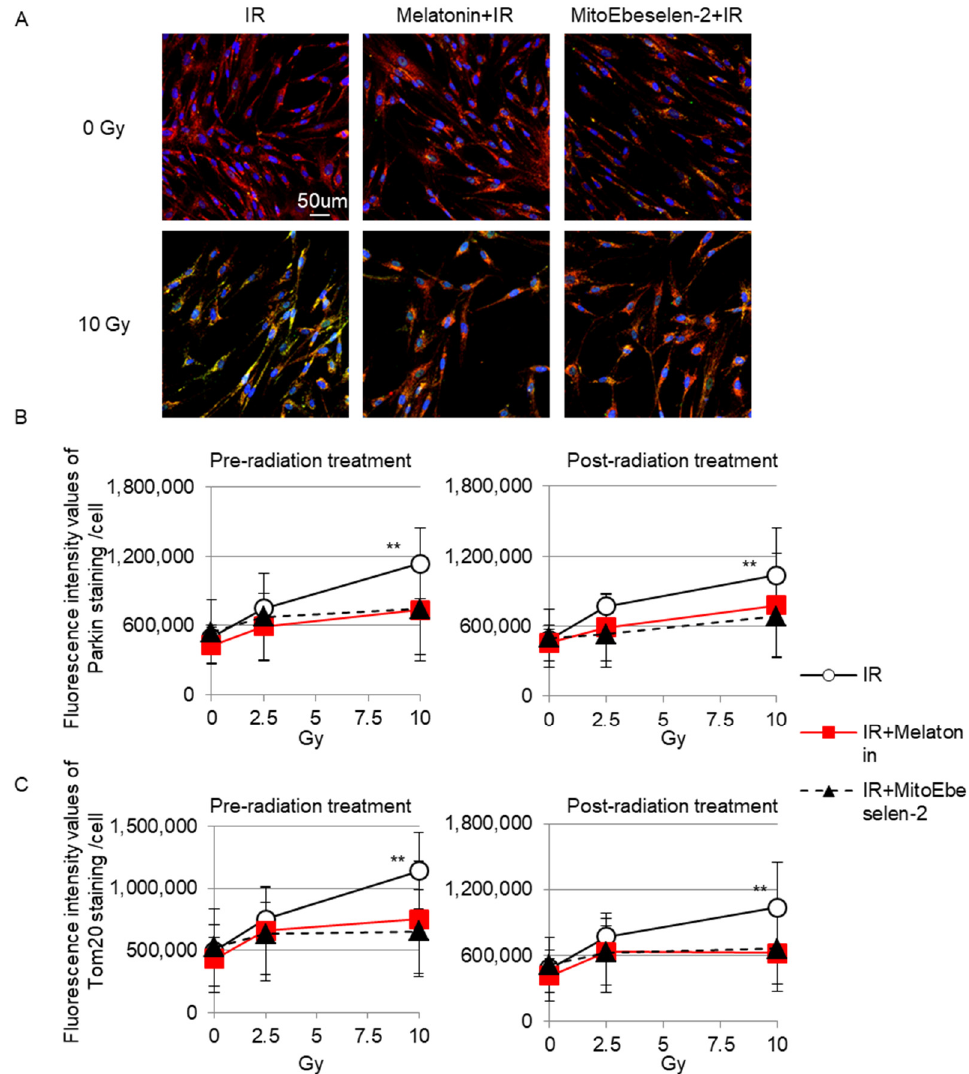
Figure 4. Mitochondrial radiation responses ( A ) Tom20 (red) and Parkin (green) positive staining were shown in irradiated TIG-3 cells. Scale bar = 50 µ m. ( B ) Fluorescence intensity of Parkin ( B ) and Tom20 ( C ) staining is indicated in the graph. Asterisk displays a significant change in fluorescence intensity values of the staining compared with that of non-irradiated control cells.